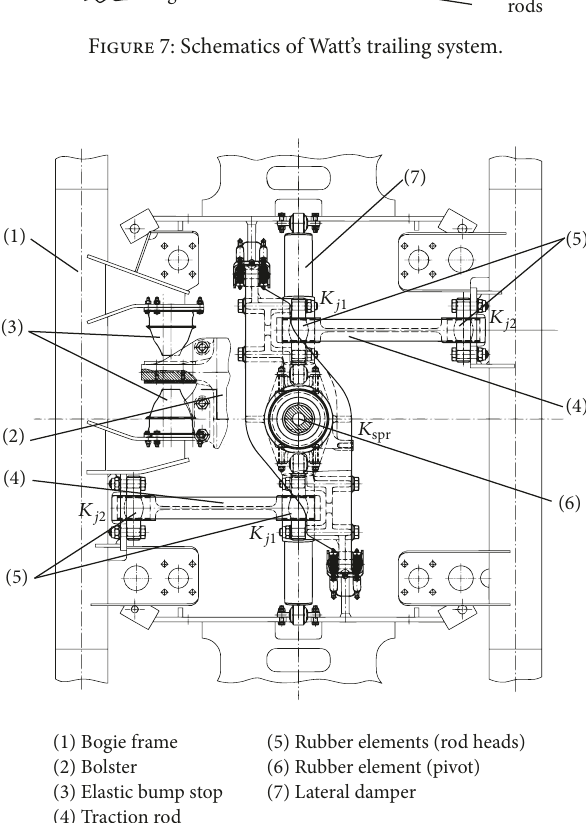
Figure 8: Detail of the bump stops used to limit the coach lateral displacement and of the traction system.